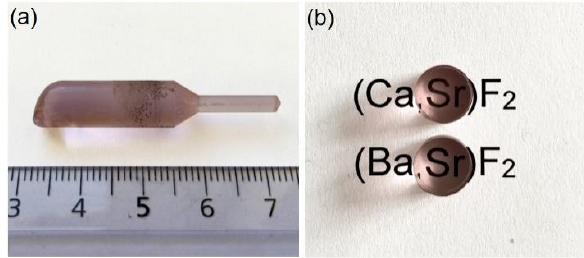
Fig. 1. (a) A photograph of an as-grown Er 3+ :SrF 2 crystal boule; (b) a photograph of laser-quality polished Er 3+ :(M 1 ,M 2 )F 2